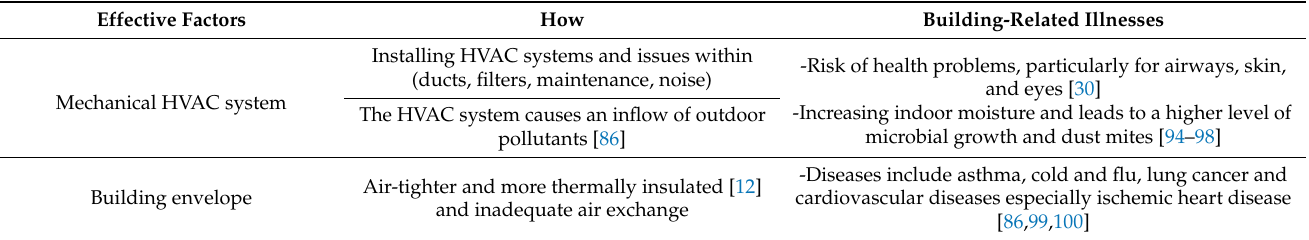
Table 5. The building and occupants’ behaviours in health